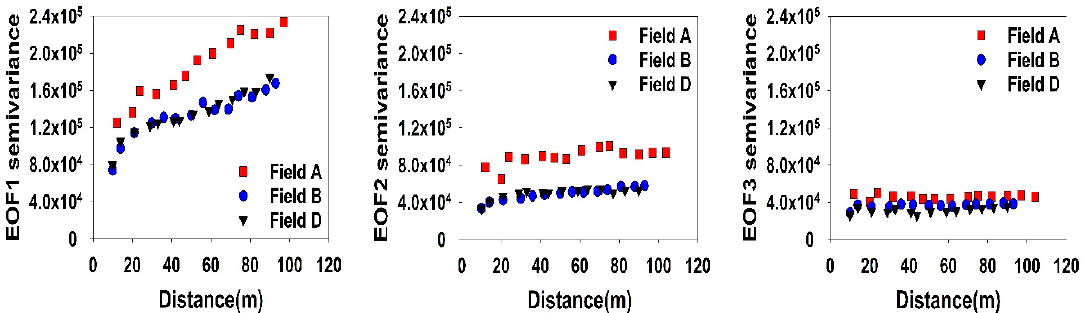
Figure 4. Semivariograms of empirical orthogonal functions EOF1, EOF2, and EOF3 of the corn yields.